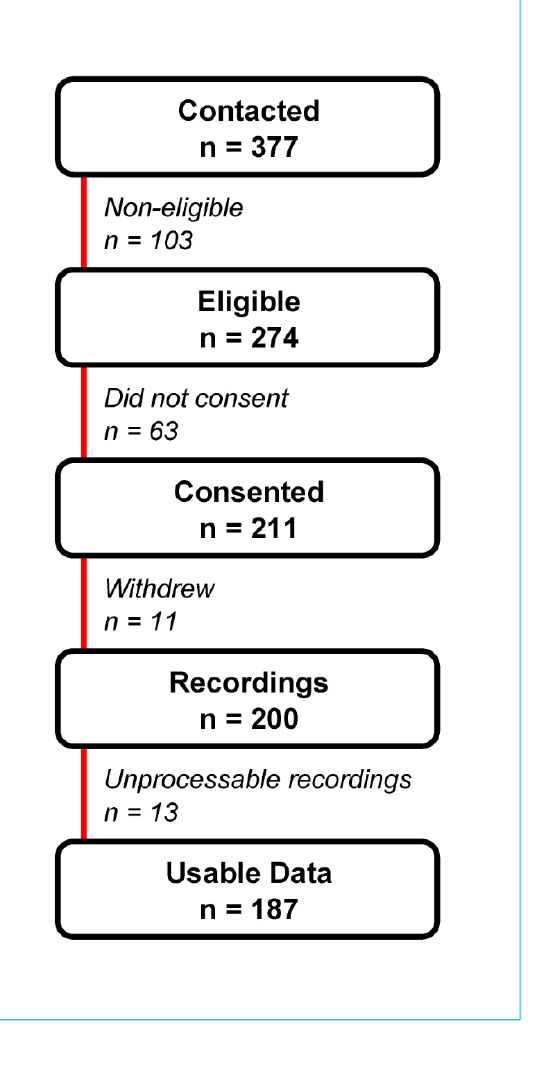
Figure S1: Selection procedures for the study population.